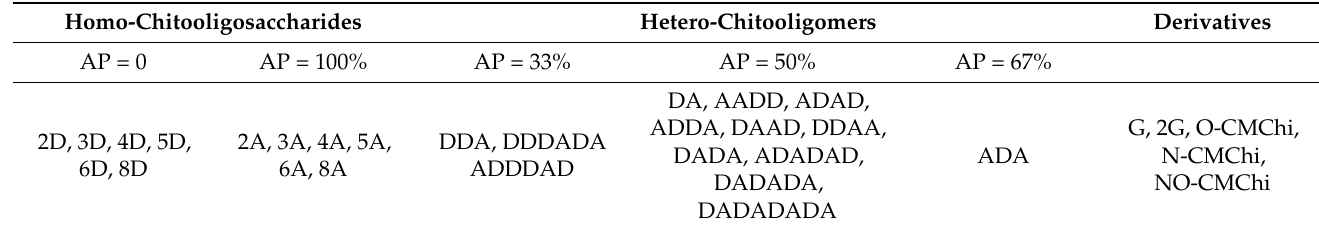
Table 4. Chitooligosaccharides and their derivatives considered in the computational study